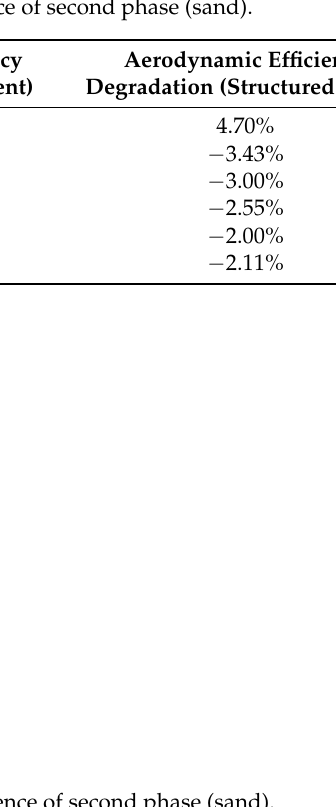
Figure 17. Static pressure distribution around airfoil at 75% of wingspan, angle of attack 20 degrees, structured mesh ( a ) one-phase flow ( b ) two-phase flow (air–sand). structured mesh ( a ) one-phase flow ( b ) two-phase flow (air–sand).